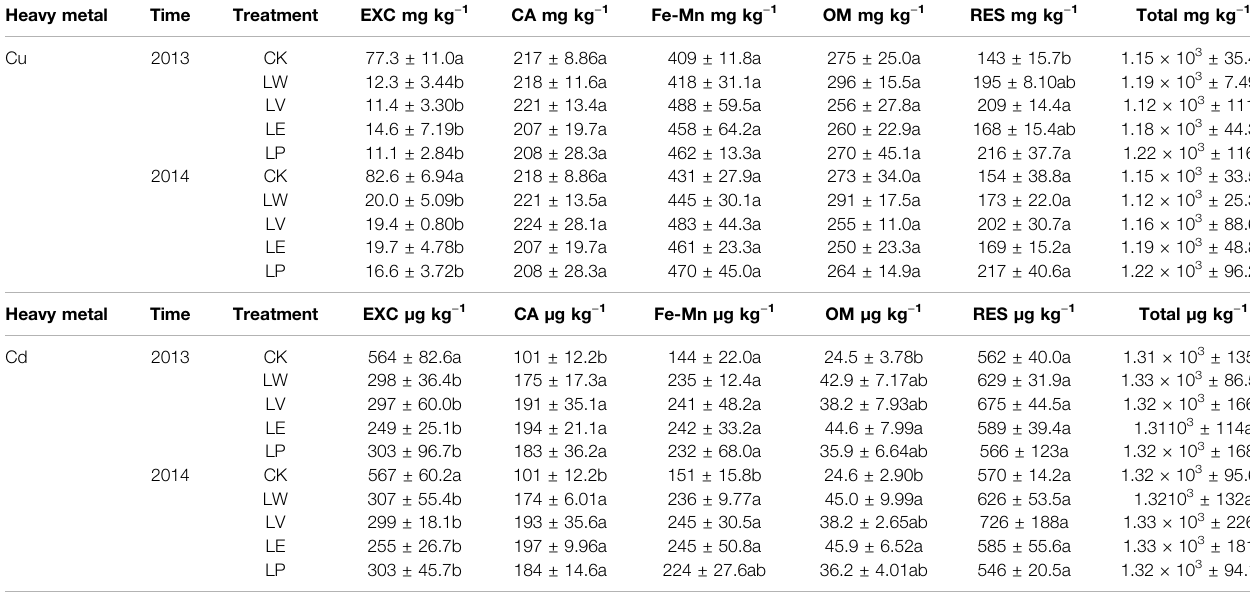
TABLE 3| SoilCuandCdfractions afterthetreatments (CK,untreated soil;LW,lime + Setaria lutescens ;LE,lime+ Elsholtziasplendens ;LV, lime+ Vetiveriazizanioides ;LP, lime + Pennisetum sp .; EXC, exchangeable fraction; CA, carbonate-bound fraction, Fe – Mn, Fe – Mn oxides-bound fraction; OM, organic matter-bound fraction; RES, residual fraction. Different lowercase letters indicate signi fi cant differences between treatments, n (cid:2) 3, p < 0.05). Heavy metal